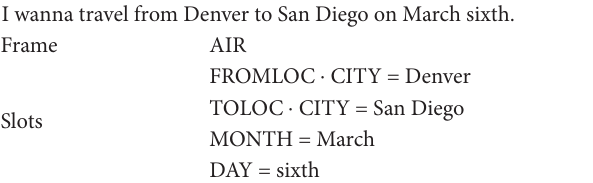
I wanna travel from Denver to San Diego on March